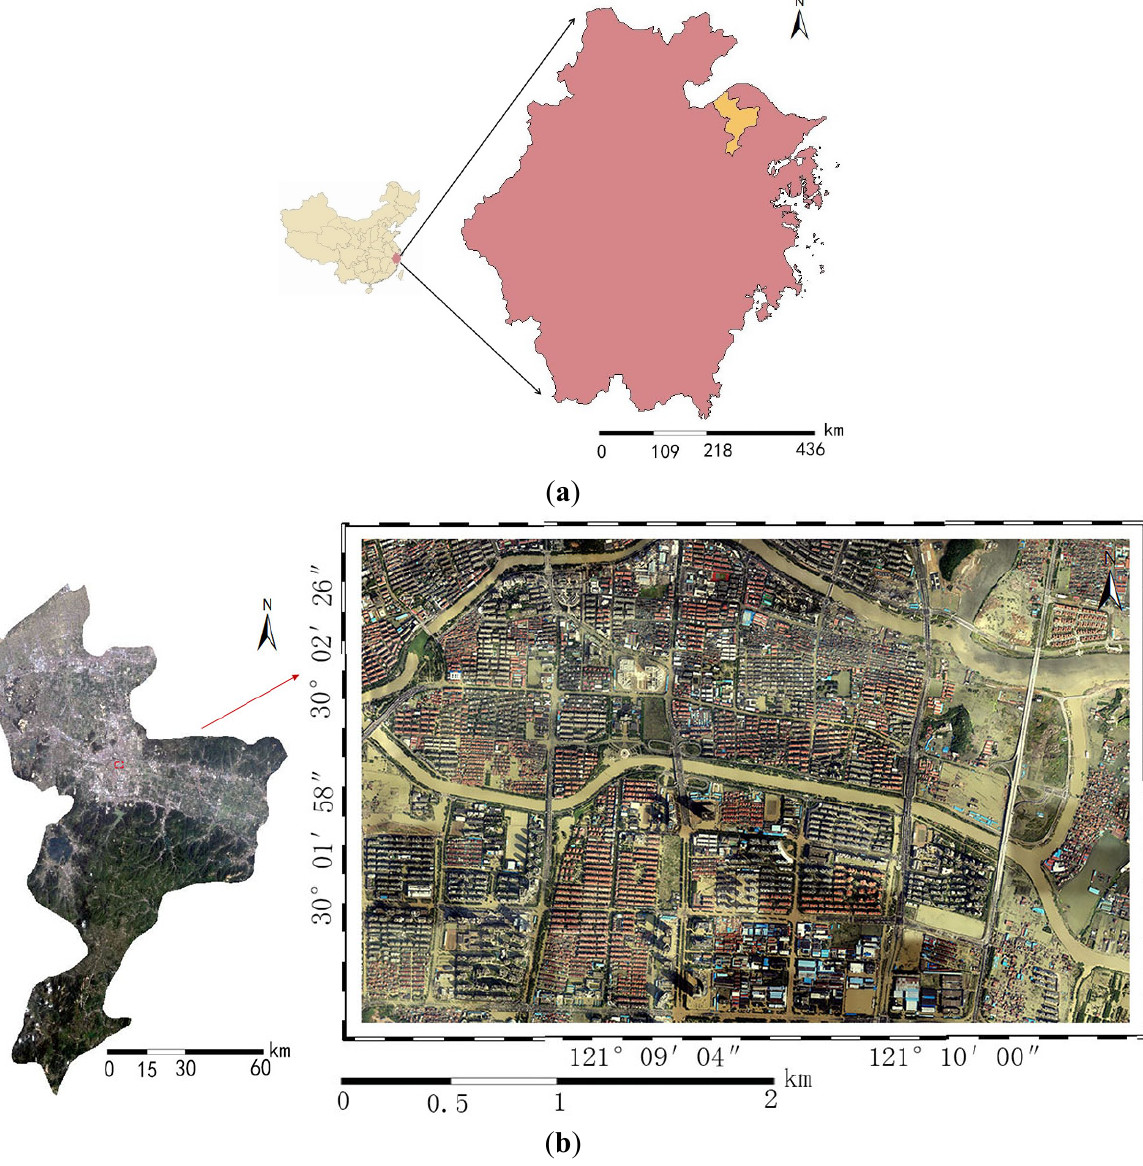
Figure 1. Study area. ( a ) Zhejiang Province; and ( b ) Yuyao